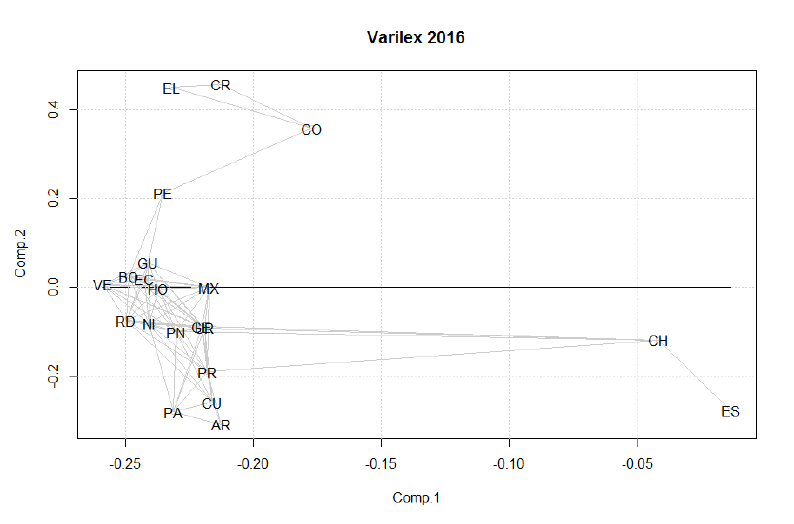
Figure 2. Representation of the first two principal components in the Varilex-R database. Country codes: AR: Argentina, BO: Bolivia, CH: Chile, CO: Colombia, CR: Costa Rica, CU: Cuba, EC: Ecuador, EL: El Salvador, ES: Spain, GE: Equatorial Guinea,